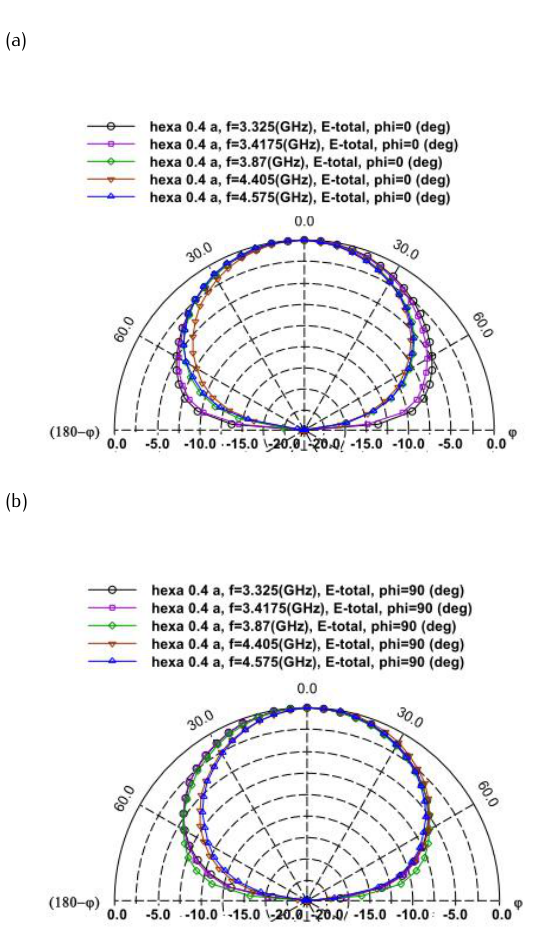
Figure 10. Elevation gain pattern of antenna as a function of elevation angle and frequencies (a) Phi=0 ◦ and (b) Phi=90 ◦ .